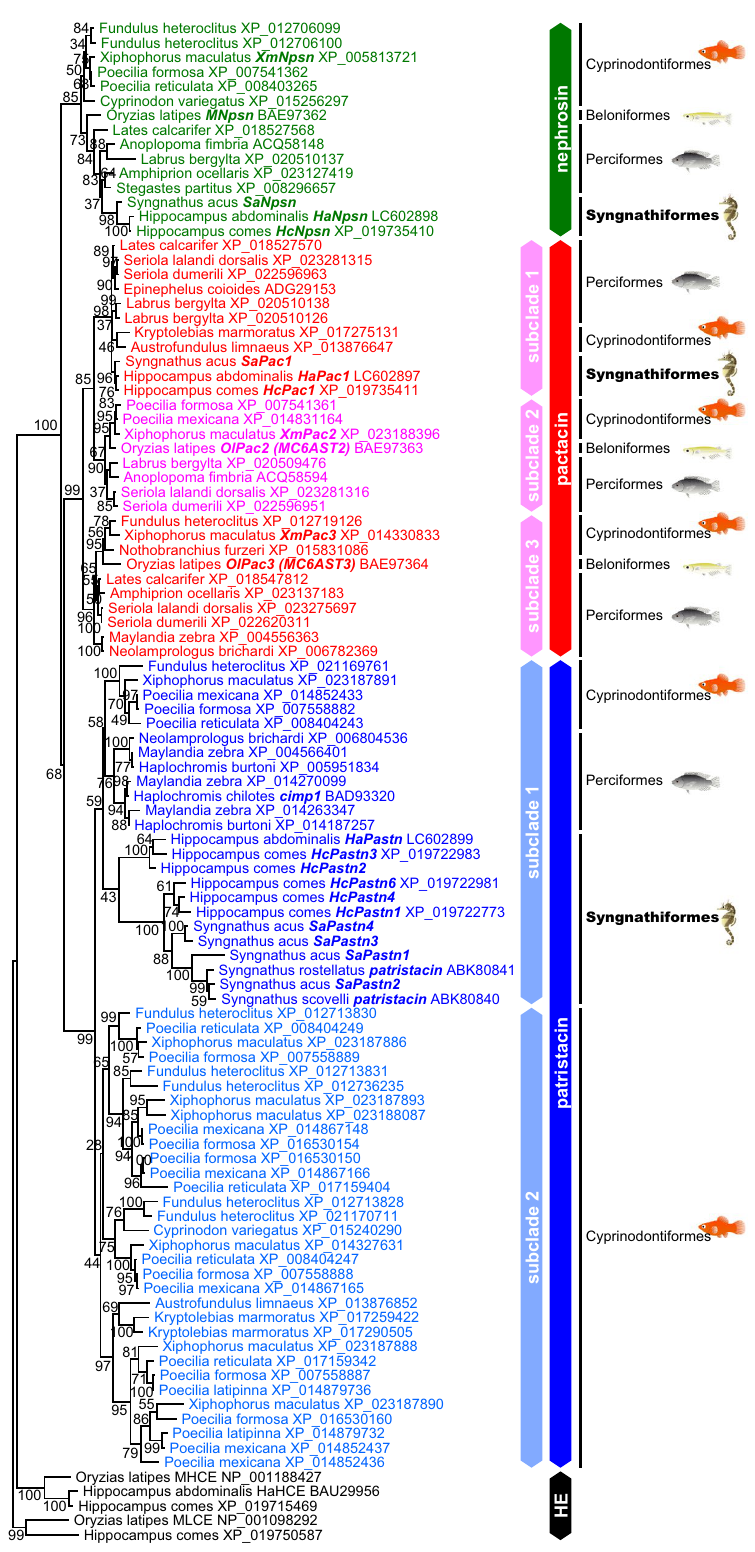
Figure 2. Maximum-likelihood tree of C6AST genes. Green, red, and blue indicate genes for nephrosin, pactacin, and patristacin, respectively. Gene names described in the present study are italicized. Node numbers indicate bootstrap values, shown as percentages. GenBank accession numbers of sequences are shown to the right of the species name. HE = hatching